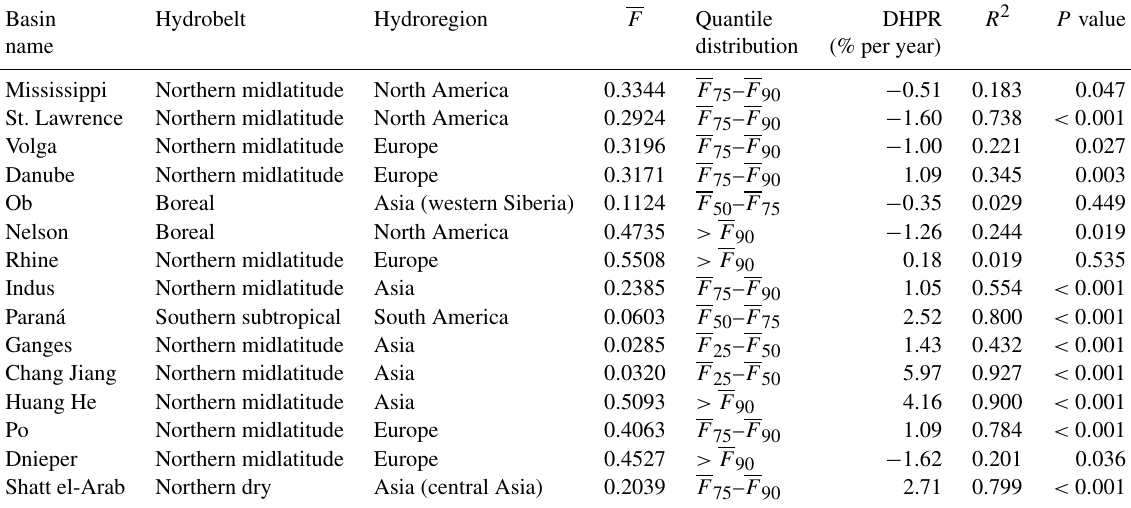
Table A2. Estimates of long-term average standardized human pressure on river systems F . River basins are ranked as a decreasing function of human presence and activity, HP. The first 15 river basins are examined. Basin name, hydrobelt, hydroregion, F and quantile distribution, DHPR values (% per year), coefficient of determination R 2 , and P values for Student’s t test are